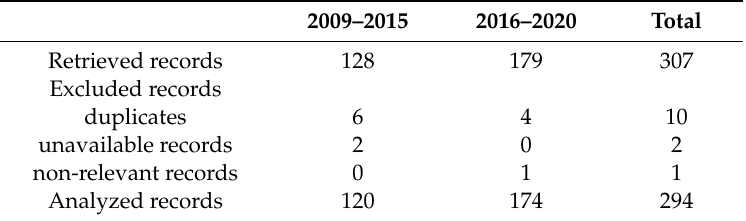
Table 3. Research sampling for the systematic literature review (number of